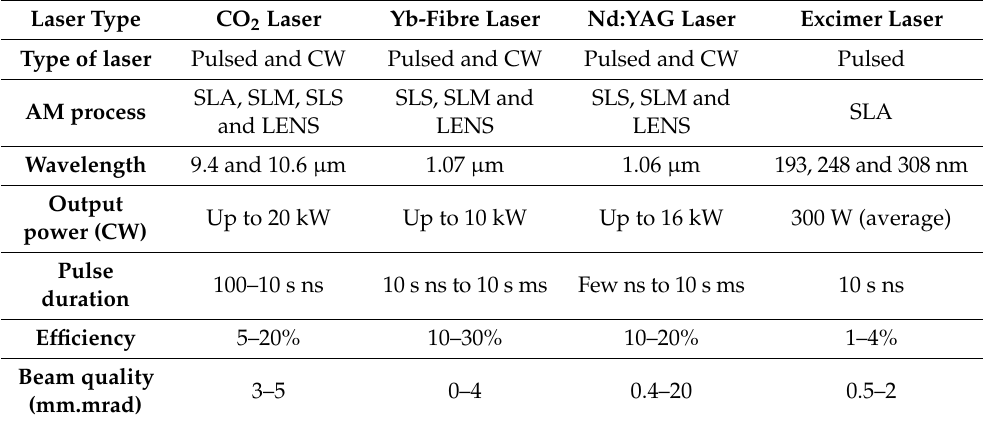
Figure 1. Summary of CW-based SLM process parameters [41]. Table 3. Types of lasers and related parameters used in AM processes [77].